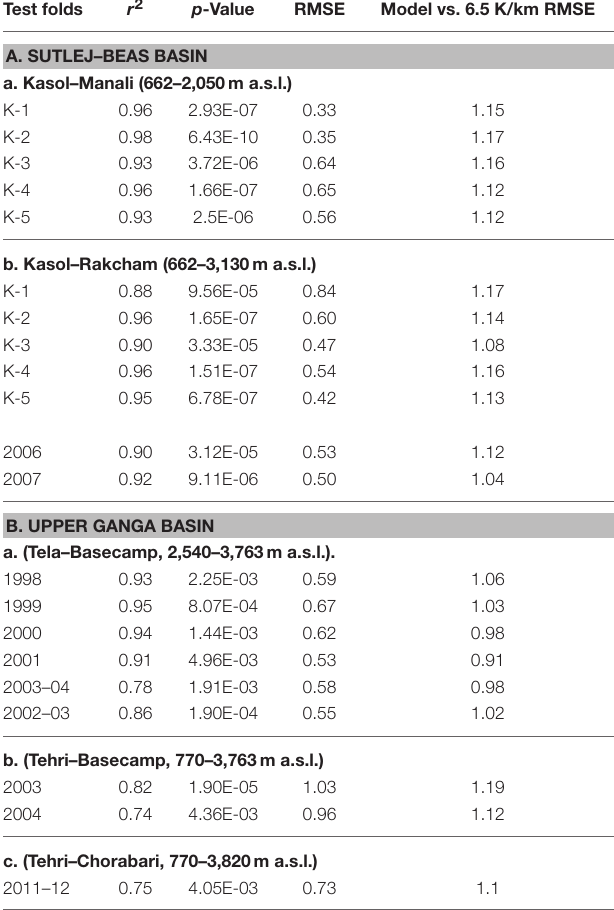
TABLE 5 | Model test statistics using regional monthly SELR indices and mean monthly temperature for (A) Sutlej–Beas basin data (a) Kasol–Manali (662–2,050m a.s.l.) and (b) Kasol–Rakcham (6,62–3,130m a.s.l.) sections and (B) for upper Ganga basin; (a).Tela–Basecamp (2,540–3,763m a.s.l.), (b) Tehri–Basecamp (7,70–3,763m a.s.l) and (c) Tehri–Chorabari (770–3,820m a.s.l) Significant improvement in the model performance using regional indices over the 5 year indices derived for Kasol–Manali section is observed. Model performance against the standard environmental lapse rate (6.5 K/km) is significantly poor as